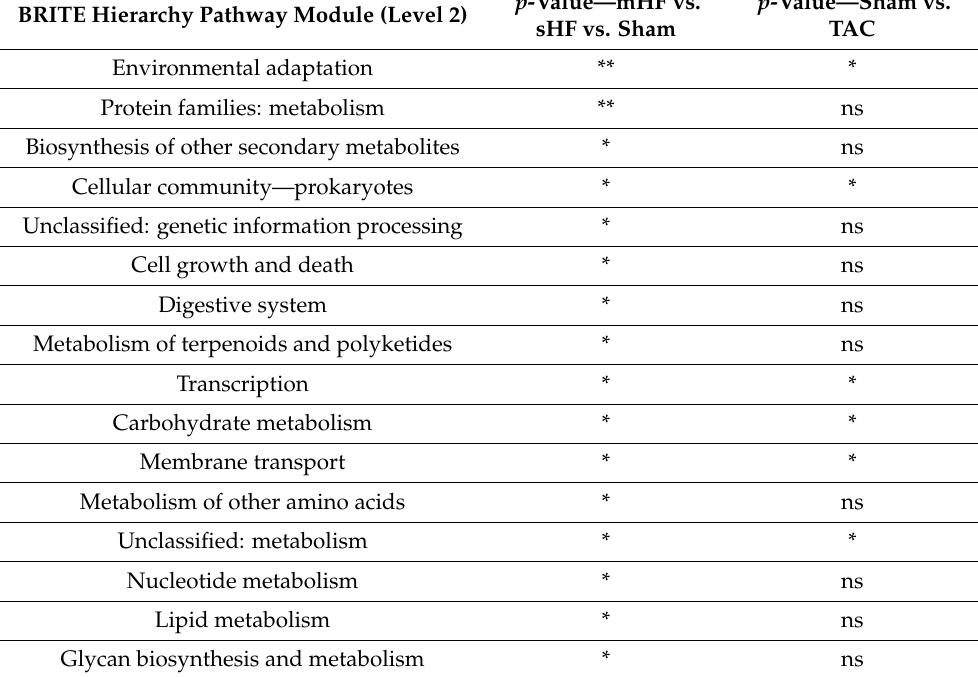
Table 1. Level 2 KEGG annotations using multivariate analysis in fecal samples of mice with sHF versus mHF versus Sham and Sham versus TAC mice (* and ** correspond to p ≤ 0.05 and p ≤ 0.01, respectively, ns: